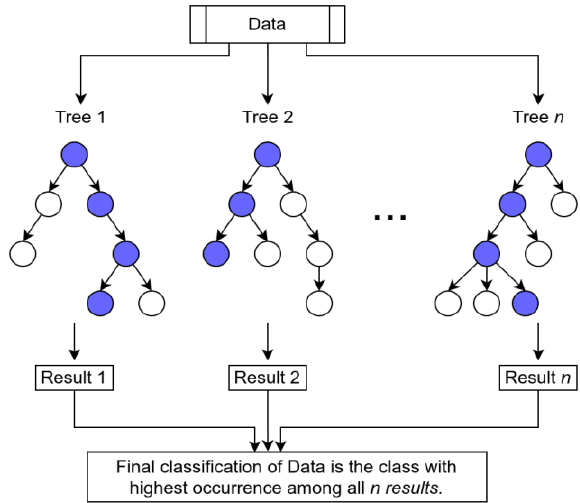
Figure 2. Diagram example of a generalisation for the classification made over Data using the Random Forest algorithm.